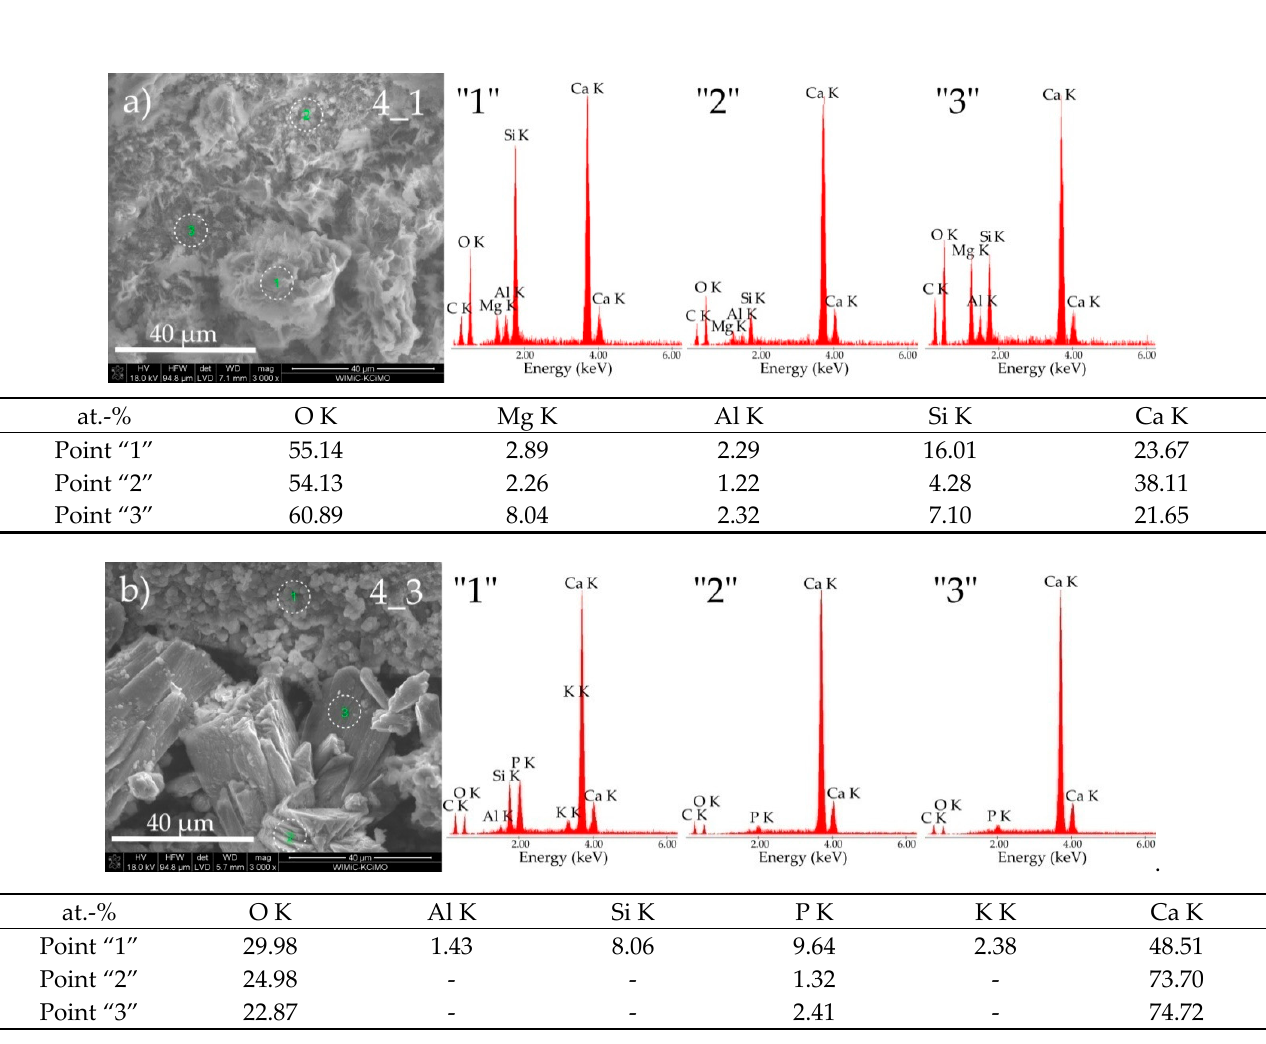
Figure 6. SEM micrographs of cement paste 4 obtained after exposure under the conditions of ( a ) water (sample 4_1) and ( b ) pig slurry (sample 4_3) with EDS quantitative point analyses from areas 1, 2, and 3.